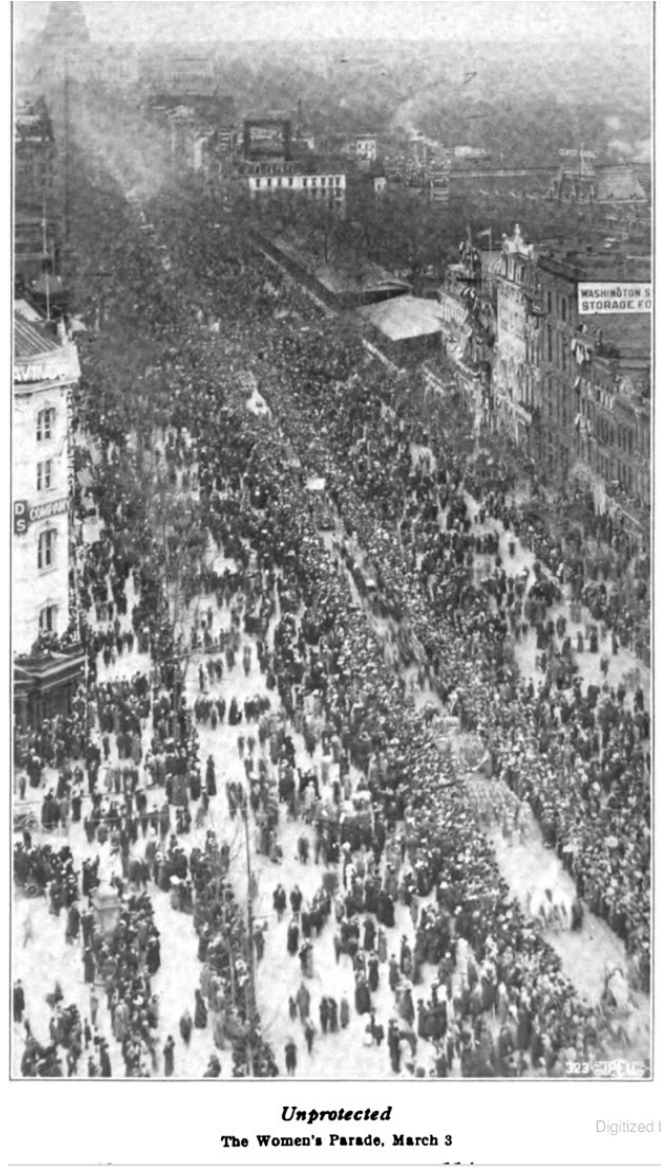
Figure 4. “Unprotected: The Women’s Parade, March 3” in Life and Labor , April 1913, p. 114. Photo credited to New York World .